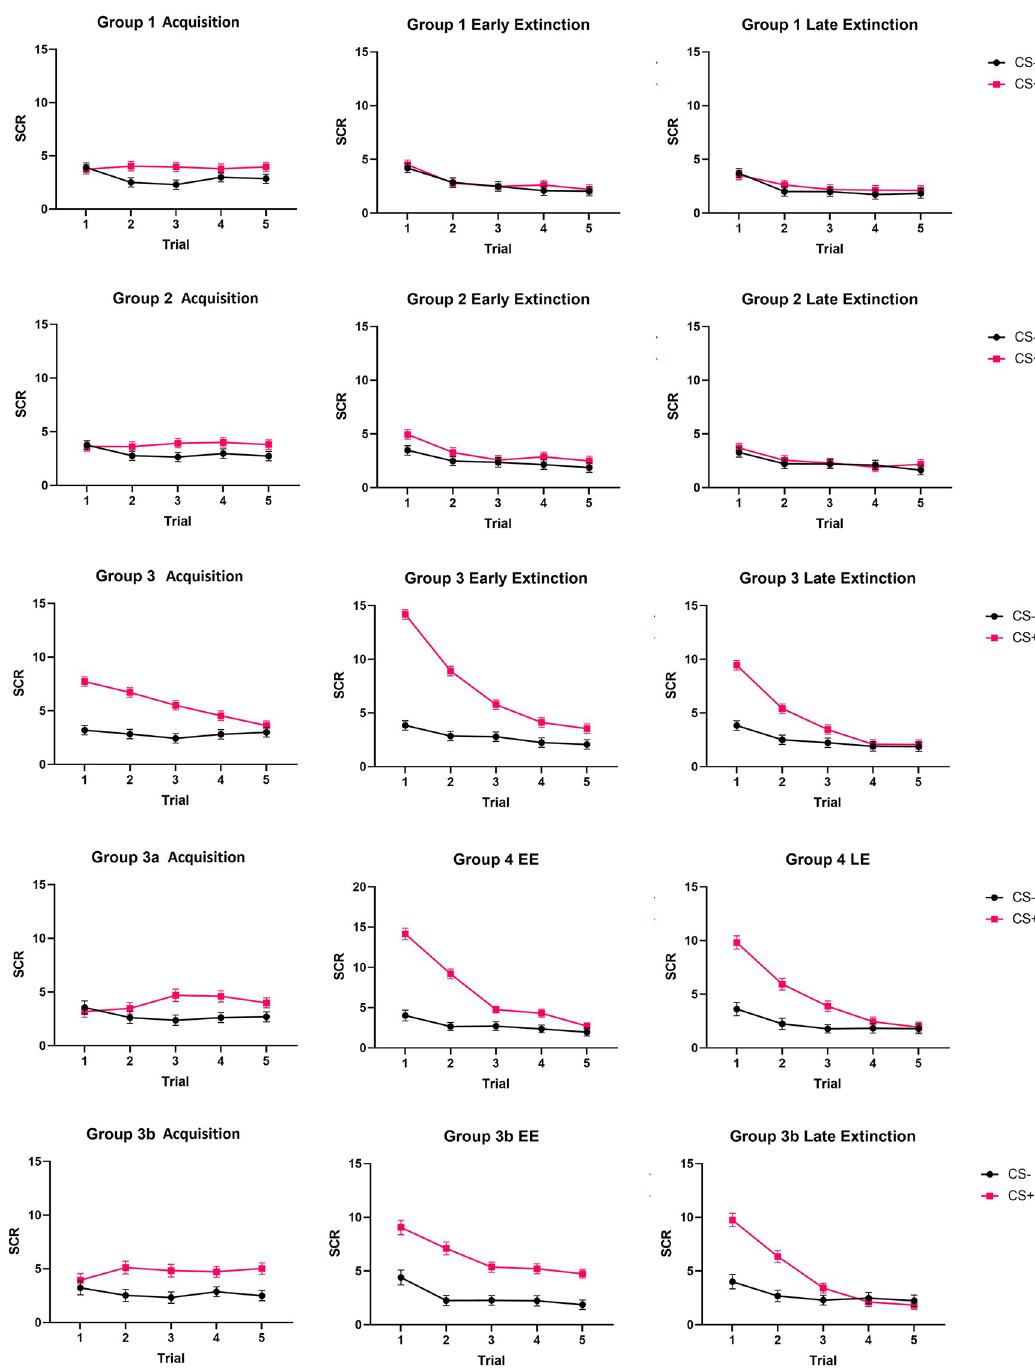
Fig 1. Example of simulated group-level effects in bootstrapped data (N = 960). SCR = Skin conductance response. Groups 3- 3b have simulated effects of differing gradients to reflect possible differences in physiological expression of acquisition and extinction between participants and between studies. Error bars are 95% Confidence